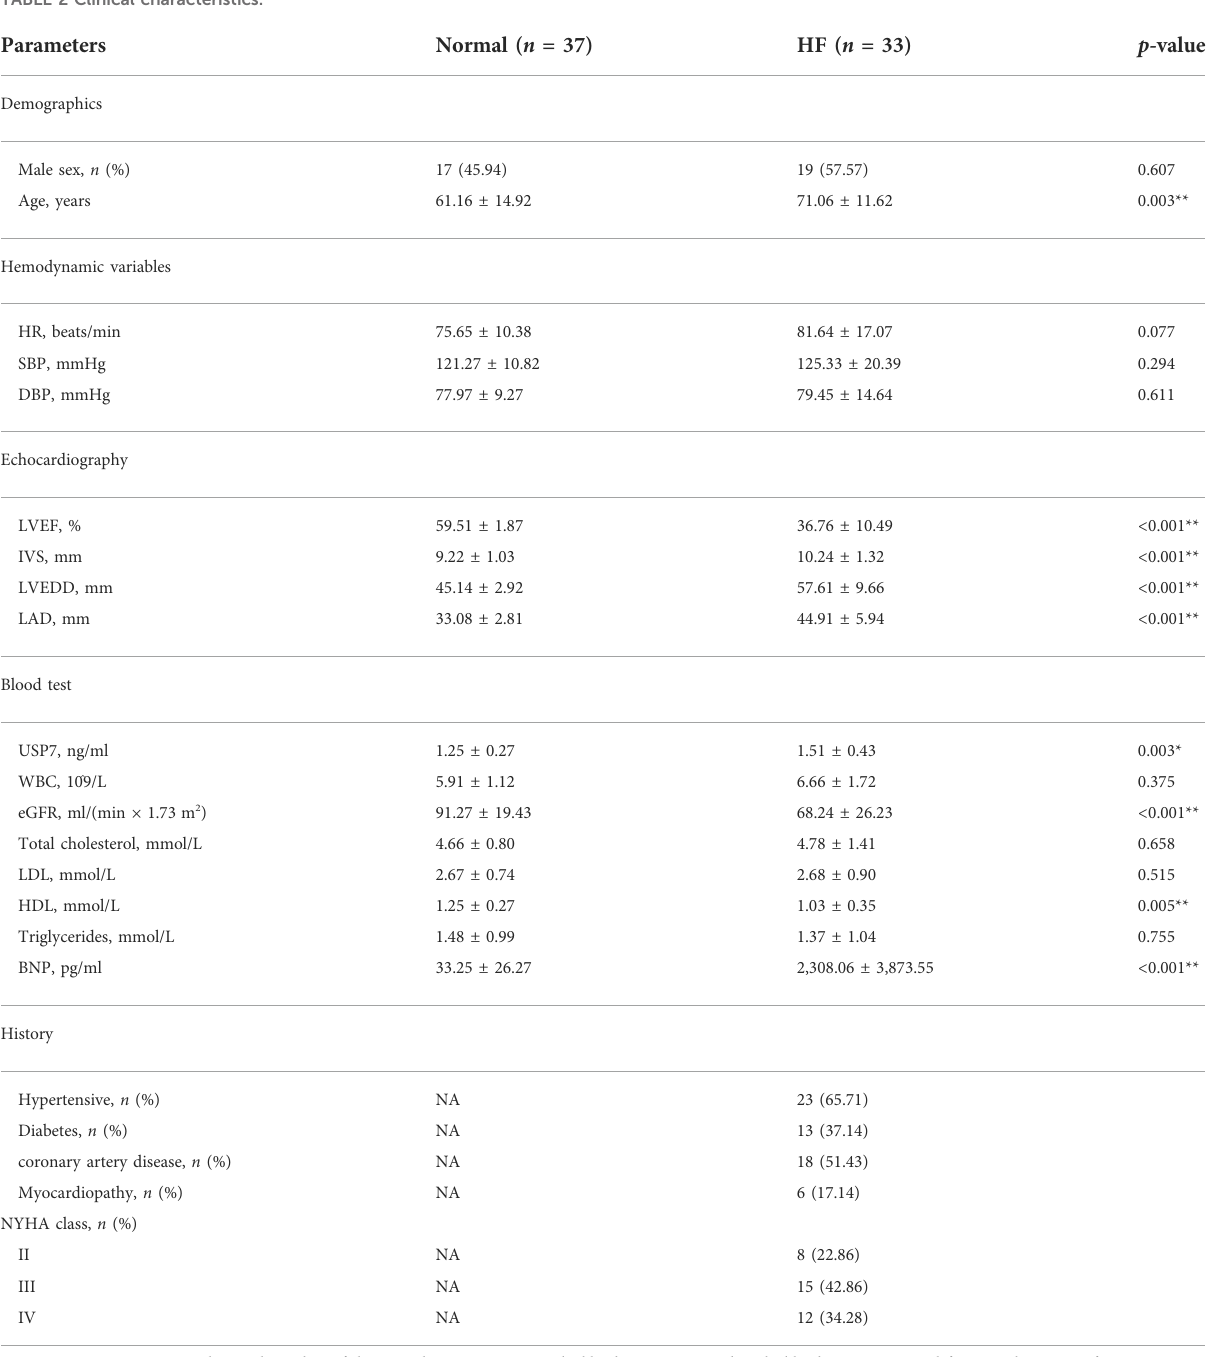
TABLE 2 Clinical